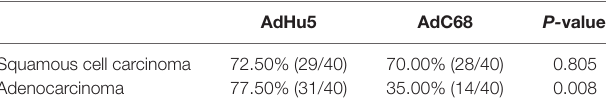
Table 6 | Seroprevalence of AdHu5 and AdC68 neutralizing antibody in subjects with different pathological type of lung cancer. adhu5 adc68 P- value